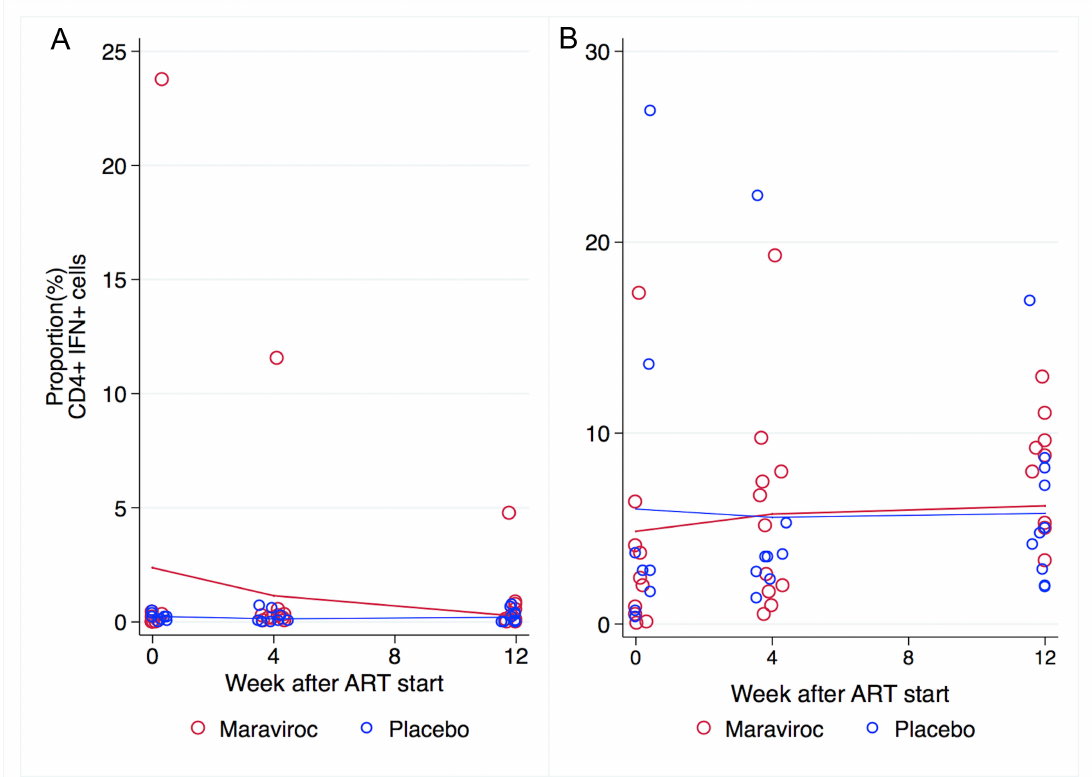
Supplementary Figure 1. Proportion of CD4 lymphocytes expressing IFNg upon exposure to CMV peptide and